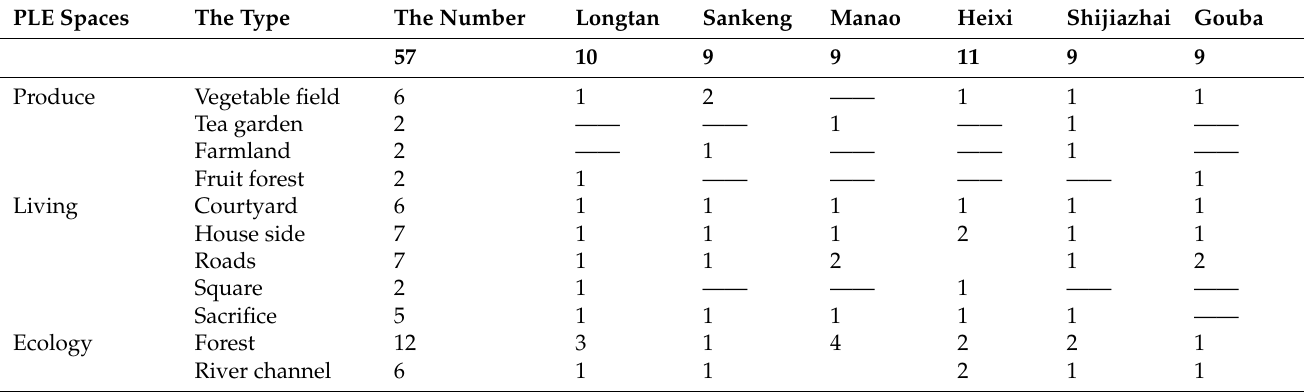
Table 3. The number of targeted microhabitats and classifications under the PLE spaces.